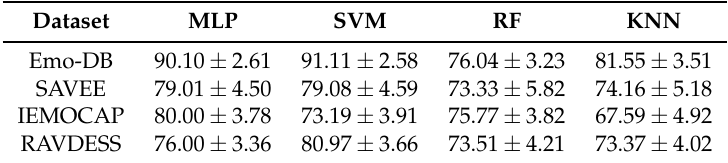
Table 1. Weighted average recall and standard deviation of Speaker-dependent SER experiments without feature